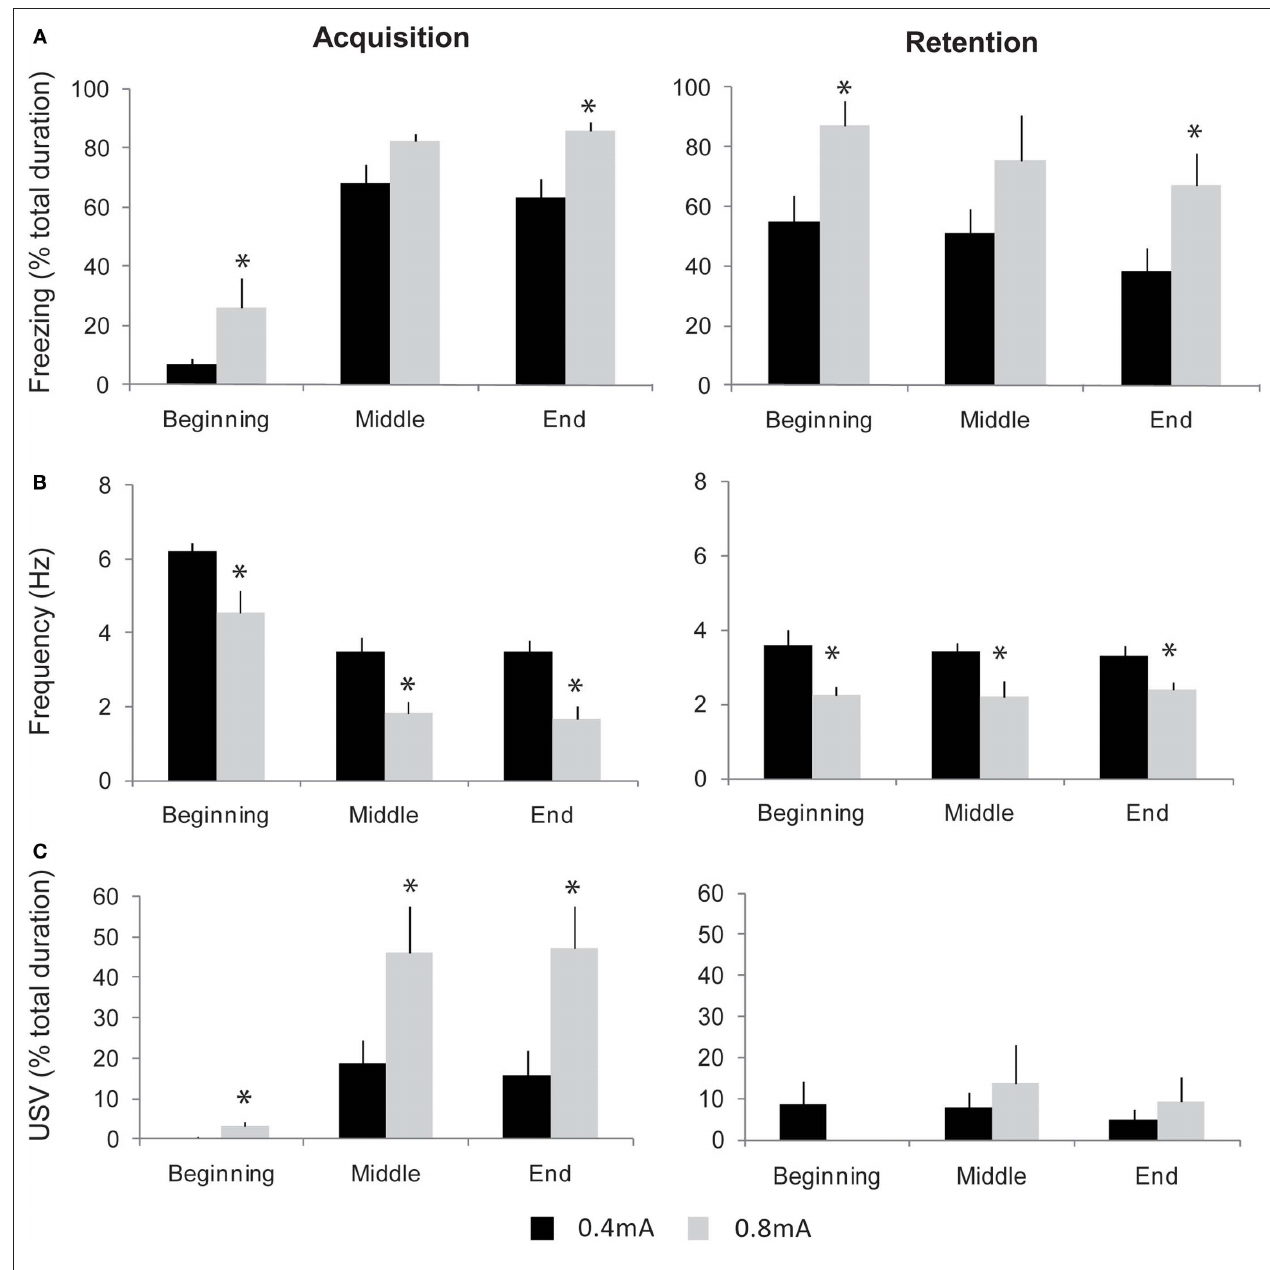
part) sessions: beginning (first foot-shock delivery), middle (after 5 foot-shocks), and end (after 10 foot-shocks). (A) Freezing behavior (mean ± SEM). (B) Respiratory frequency (mean ± SEM). (C) USV response duration (mean ± SEM). *Significant difference between 0.4 and 0.8 mA animals, p